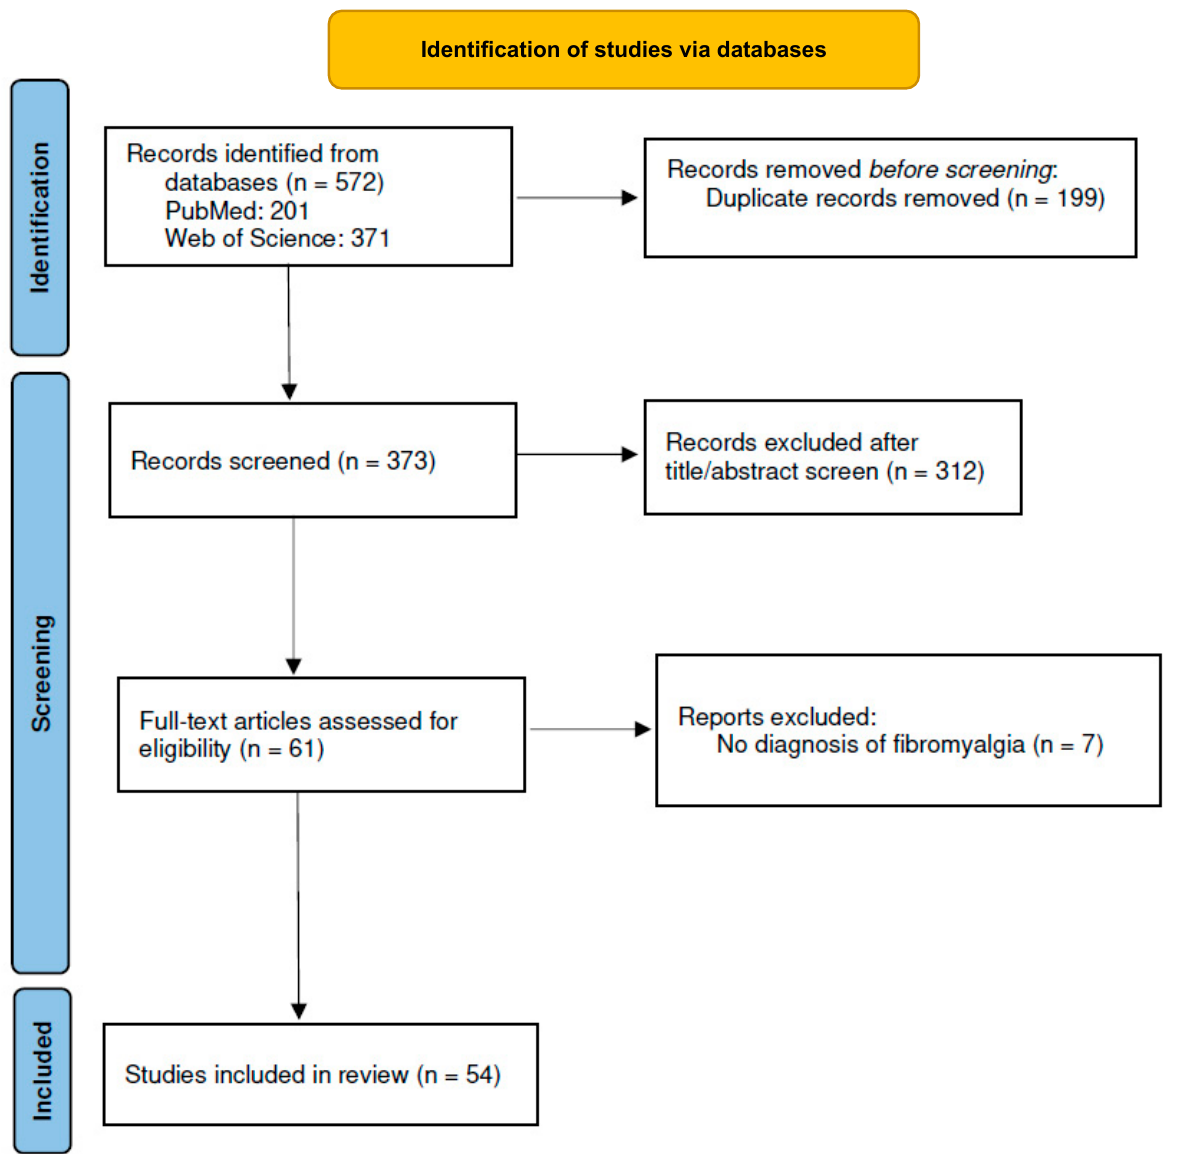
Figure 1. Preferred Reporting Items for Systematic Reviews and Meta-Analyses (PRISMA) flow diagram of included studies (408422).